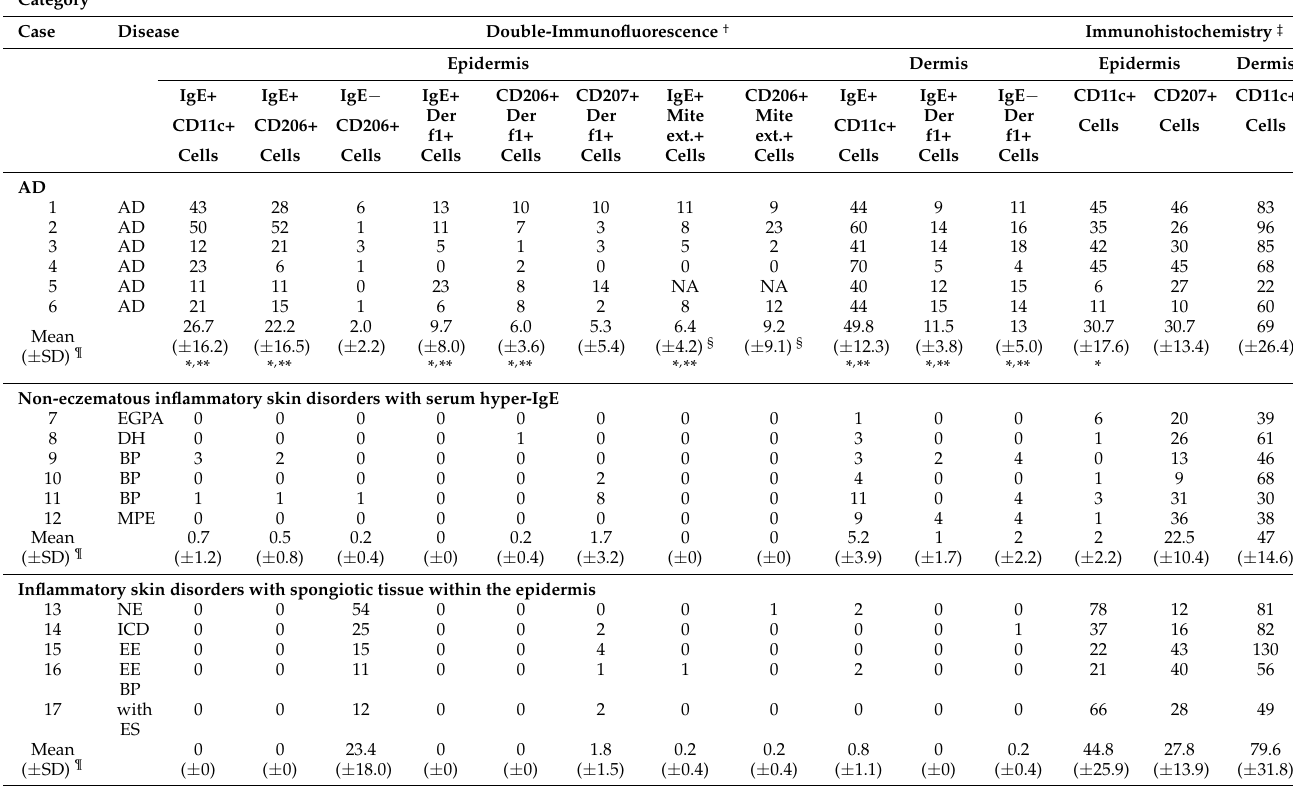
Table 2. Double-immunofluorescence and immunohistochemical staining results for the main analyses of infiltrating cells with immune markers for IgE, dendritic cells, and house dust mite antigens in skin lesions of atopic dermatitis patients and the control subjects.